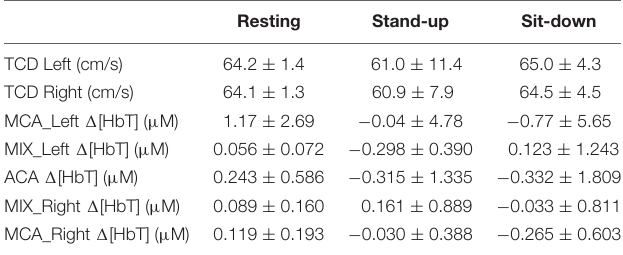
TABLE 2 | Cerebrovascular variables derived from NIRS- and TCD-measurements. Resting Stand-up Sit-down